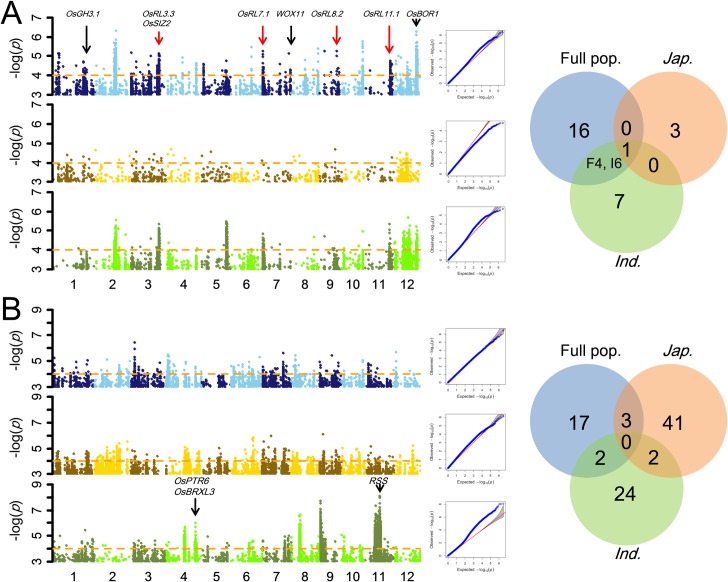
Identification of robust-root QTLs by GWAS.Manhattan plots and quantile-quantile (Q-Q) plots in the whole population (upper left, blue), japonica (middle left, yellow) and indica (lower left, green) and Venn diagram of QTL number detected in different populations (right) for (A) root length and (B) root thickness. Black and red arrows mark six known genes and five QTL genes identified/confirmed in this study in their corresponding QTLs, respectively. F4 and I6 in the Venn diagram showed that 4 QTLs in whole population overlapped with 6 QTLs in indica.